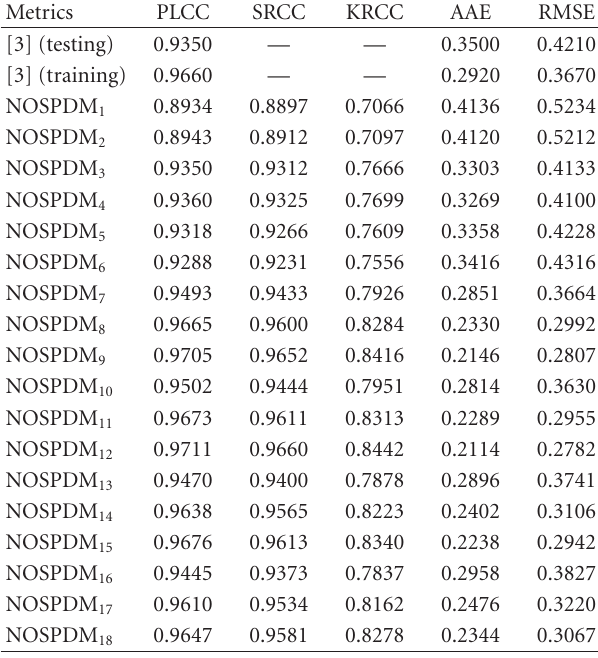
Figure 1: Illustration of qualities of stereoscopic images with the same “computer” image content versus qualities of their correspon- ding left and right images. MOS(3D), MOS( L ), and MOS( R ) indi- cate MOS values of stereoscopic, left and right images, respectively. Table 1: Demands for the chosen image groups for testing the “dis- tress” feeling.